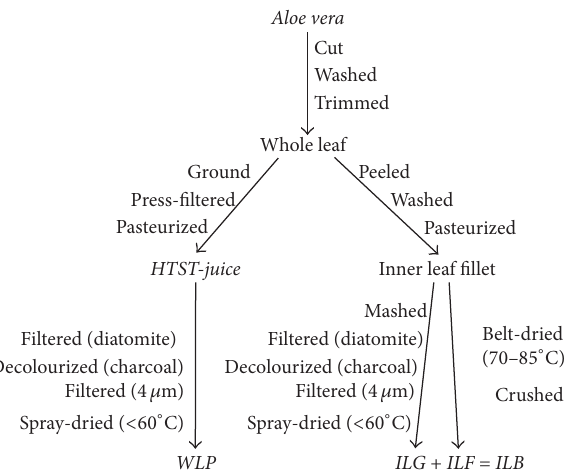
Figure 1: Sample preparation scheme. Leaves from Aloe vera are cut, washed, and trimmed to get the whole leaves. For HTST-juice, the whole leaves are ground to a particulate slurry, which is press- filtered, and the resulting juice is pasteurized. Whole leaf powder is produced by filtration of HTST-juice through diatomaceous earth, and the aloin content is then reduced by charcoal treatment, which itself is removed by another filtration; the resulting liquid is spray- driedresultingina100xconcentratedpowder(WLP).Thewholeleaf canalsobepeeled,washed,andpasteurizedtogettheinnerleaffillet. This fillet can be mashed and then treated like HTST-juice to get a 200xconcentratedinnerleafgel(ILG)powder,oritcanbe(probably sliced) belt-dried and crushed to get a 200x concentrated inner leaf gel powder, rich in fibres (ILF). The main difference between WLP/ILG and ILF is that the latter has no charcoal treatment and is exposed to higher temperatures during the drying process. The 1 :1 mixture of ILG and ILF results in a 200x inner leaf blended (ILB)